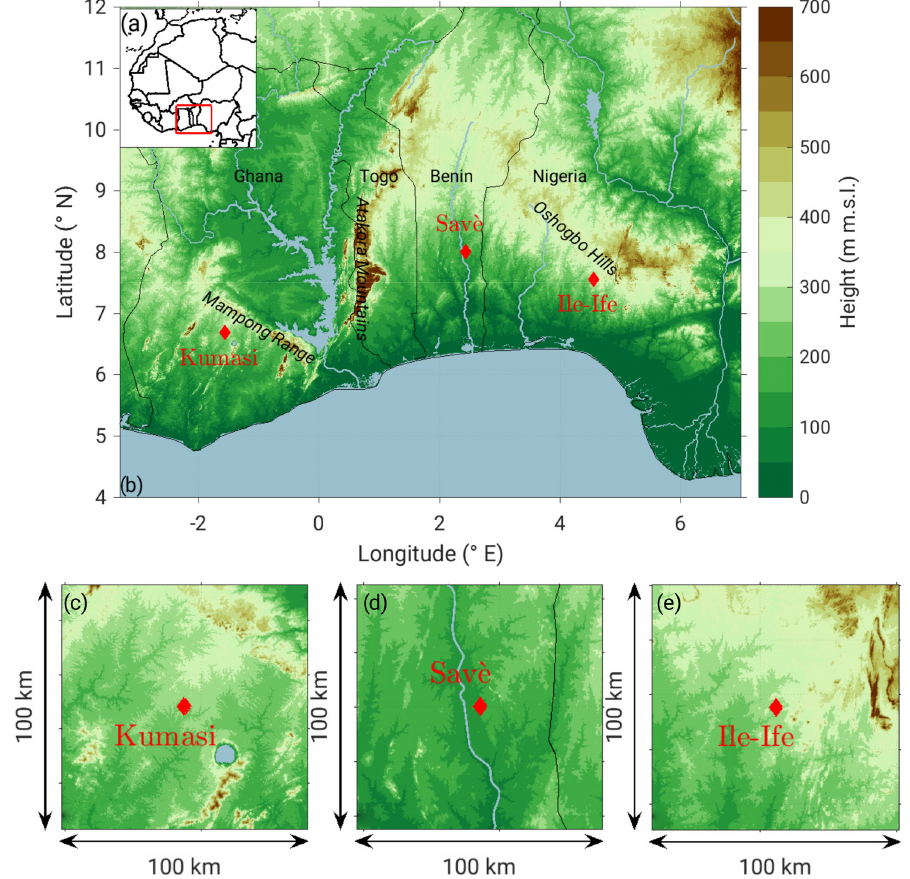
Figure 1. Location of the DACCIWA investigation area (red box) in West Africa (a) and orography in the investigation area with the locations of the three supersites Kumasi in Ghana, Savè in Benin and Ile-Ife in Nigeria (b) . More detailed orography in the immediate surrounding of the three supersites Kumasi (c) , Savè (d) and Ile-Ife (e) . Solid lines indicate country borders with country names given in (b) .